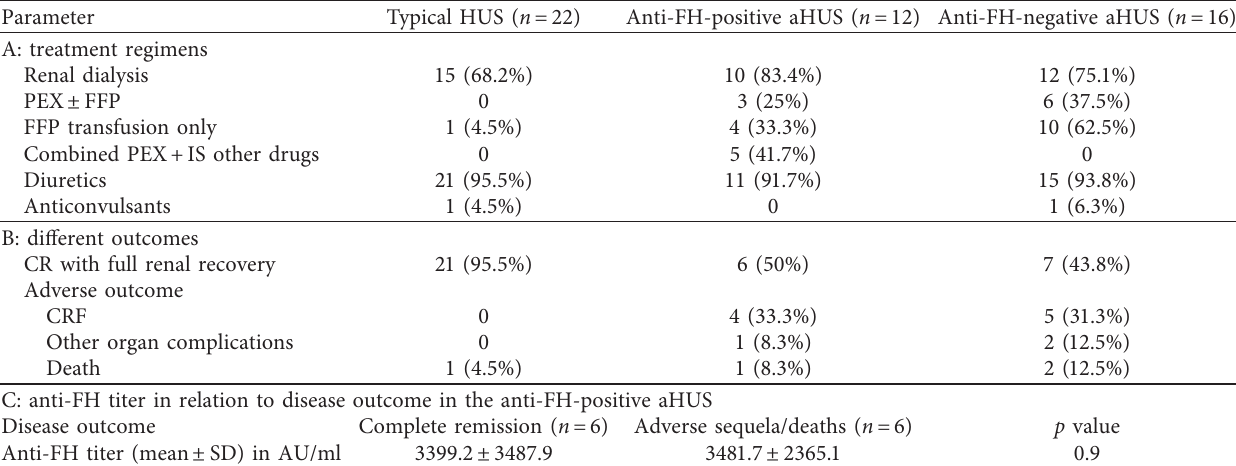
Table 4: Treatment regimens and different outcomes among HUS